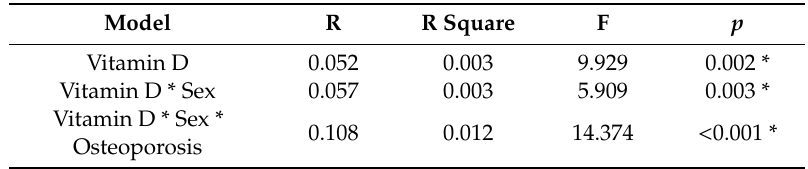
Table 4. Interactions among vitamin D, sex, and osteoporosis for the relation with the vestibular problems in the modified Romberg test.